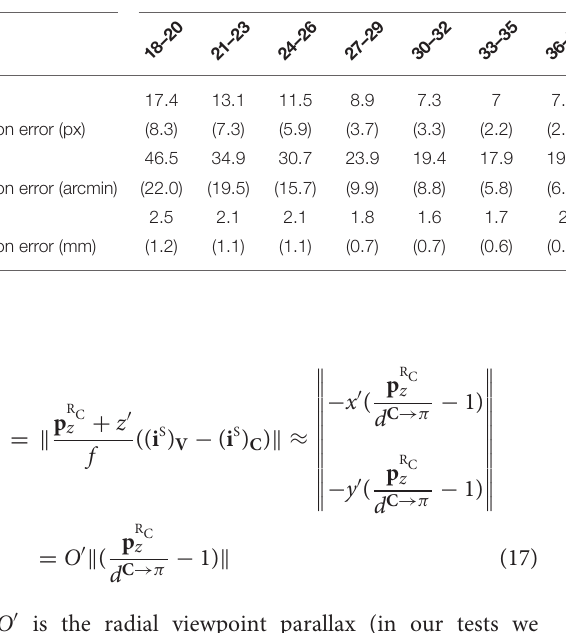
TABLE 3 | Registration error measured at different viewpoint-to-checkerboard distances for all the positions of the mounting template. Mean Checkerboard distances